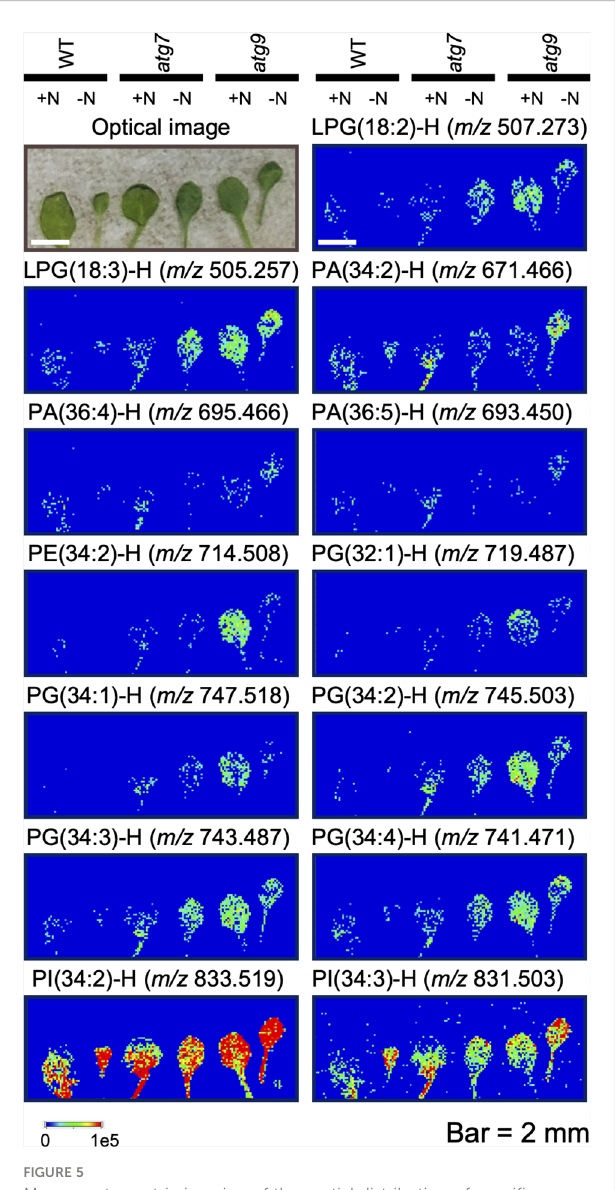
transcriptome is larger in the atg7 mutant than the atg9 mutant, we were